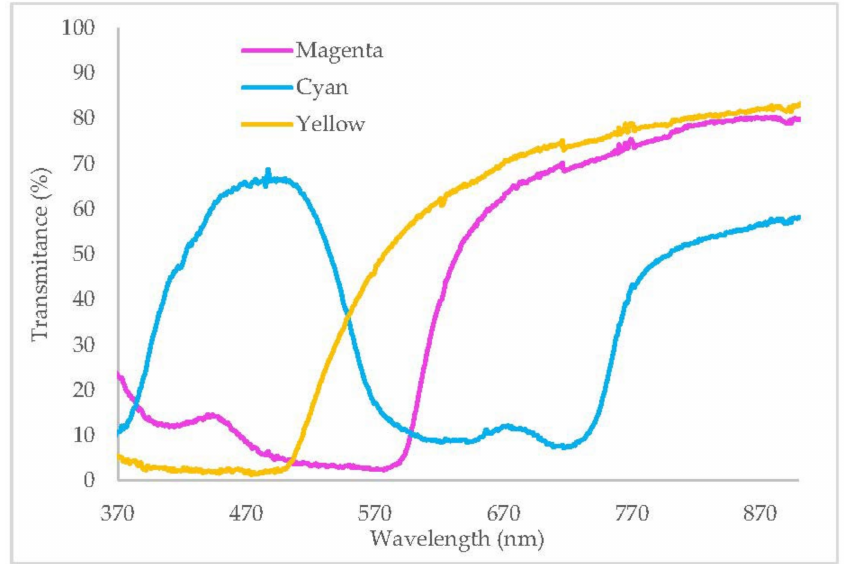
Figure 2. Transmittance spectra of lithography inks measured with a HP UV-vis spectrometer. The ink was rolled onto glass slides.